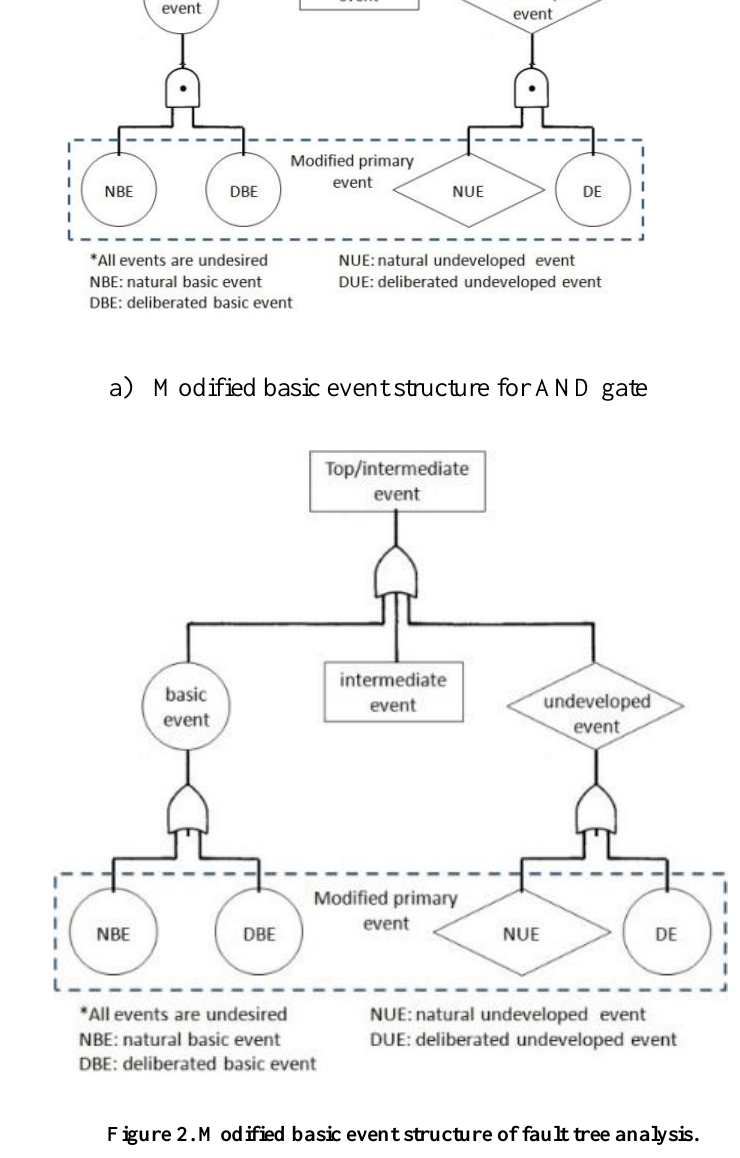
Figure 2. Modified basic event structure of fault tree